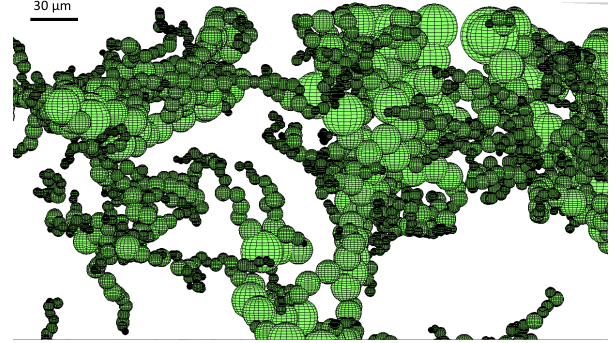
Fig. 4. Details of the maximal spheres covering the pore space of the sand. Figure 4: Details of the maximal spheres covering the pore space of the sand